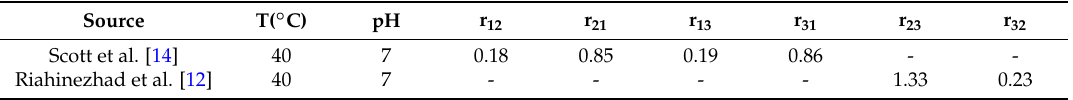
Table 1. Binary reactivity ratios for copolymerizations associated with